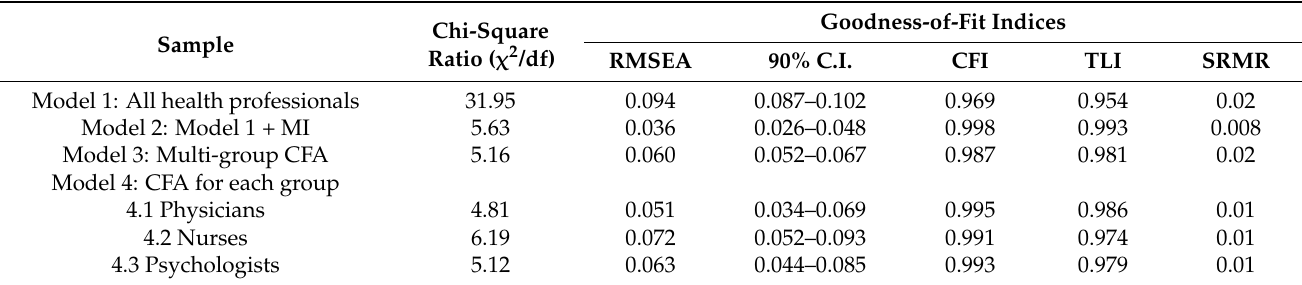
Table 2. Results of confirmatory factor analyses.